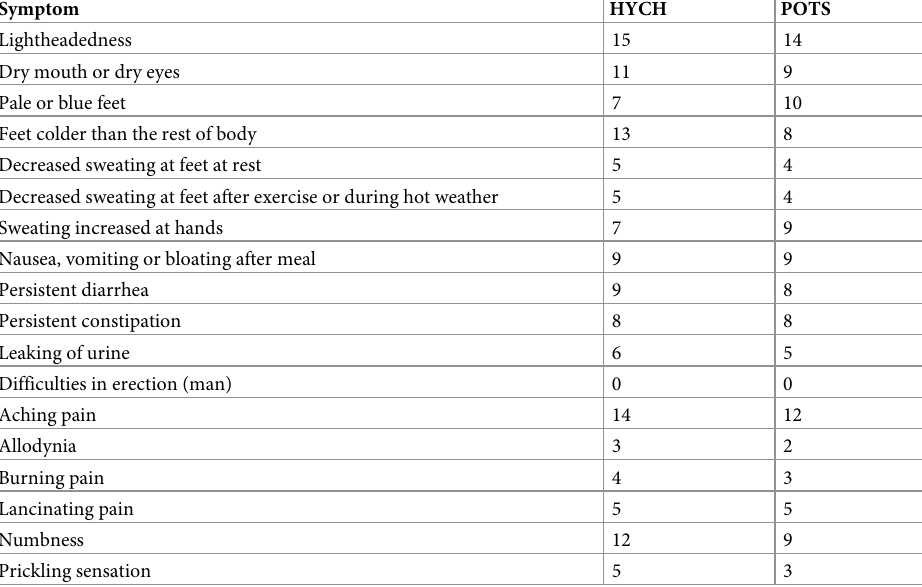
Table 1. Frequency of symptoms in patients with HYCH and